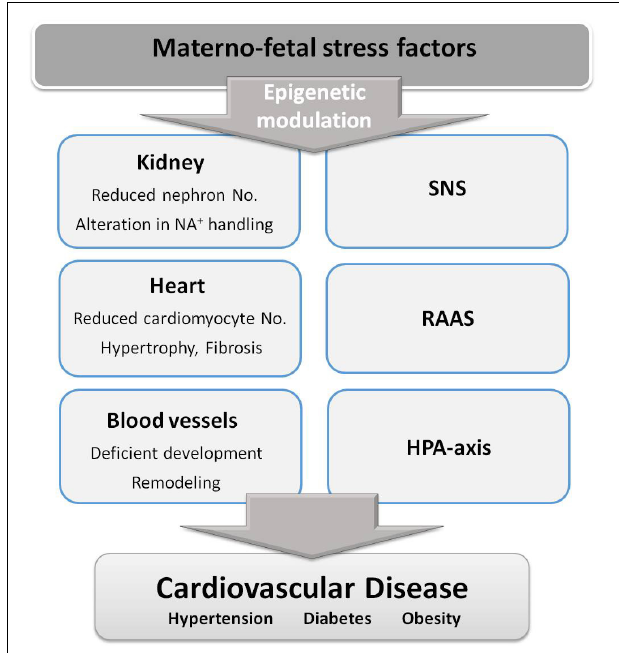
FIGURE 2 | Stress factors during fetal life alter several organs and physiological systems, through epigenetic changes, contributing to cardiovascular disease development. SNS, sympathetic nervous system; RAAS, renin-angiotensin-aldosterone system; HPA-axis, hypothalamic-pituitary-adrenal